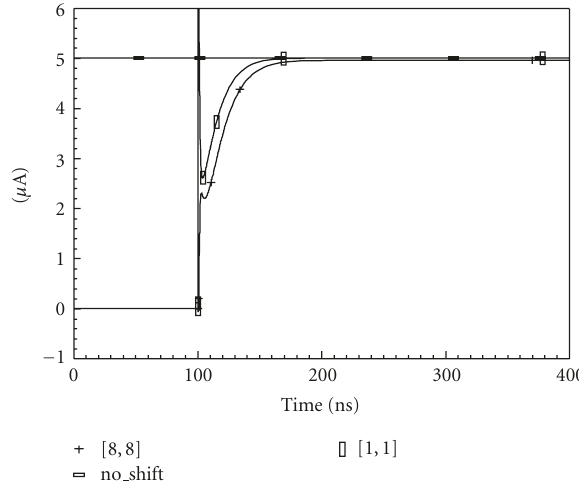
Figure 8: Transient simulations of [0,0], [1,1], and [8,8] shifts, with high-speed transistor